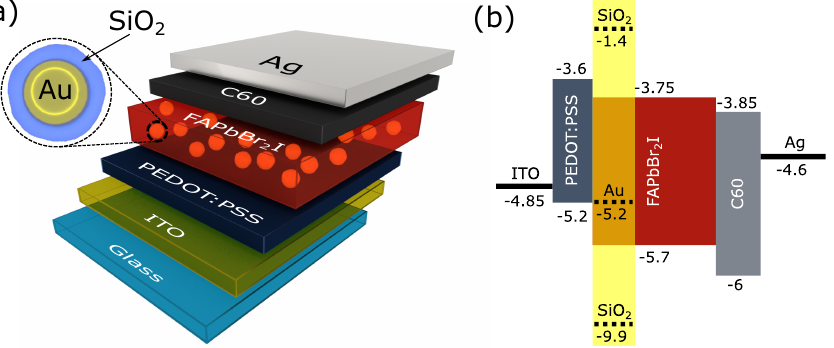
Figure 3. ( a ) Perovskite light-emitting diode (PeLED) structure representation; ( b ) Simplified energy band alignment of the multilayered PeLED device showing the conduction and valence band energy levels with respect to the vacuum level. Yellow insert corresponds to core-shell NPs located inside FAPbBr 2